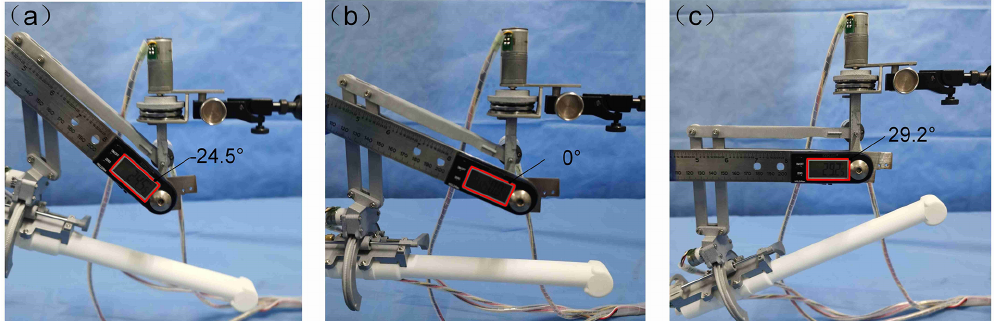
Figure 12. Actual measured value of the pitch angle.